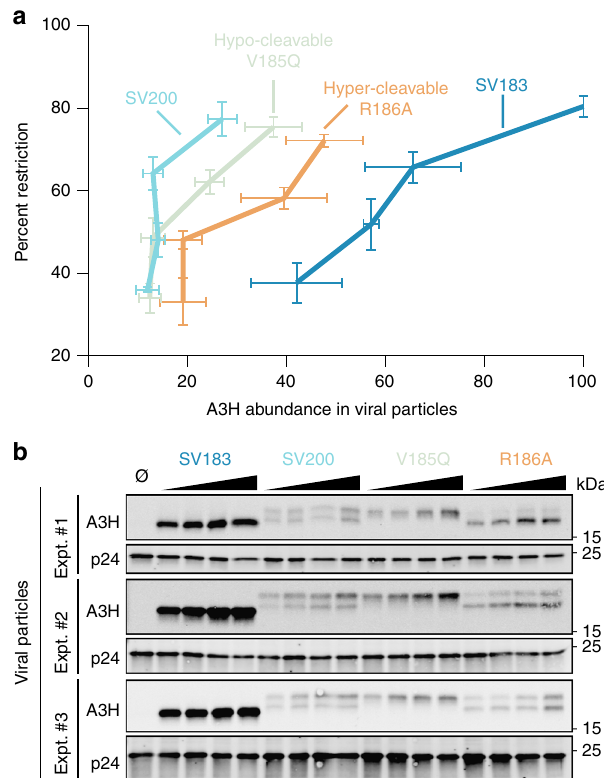
Fig. 6 Quanti fi cation of HIV-1 restriction for A3H haplotype II SV200 and hypo- and hyper-cleavable derivatives. a Dose – response summary of infectivity data for Vif-de fi cient HIV-1 LAI produced in 293T cells in the presence of the indicated untagged A3H splice variants (12.5 ng, 25 ng, 50 ng, or 100 ng) and infectivity quanti fi cation by fl ow cytometry of infected CEM-GFP reporter T cells. Each data point represents the mean of three biologically independent experiments. The percent restriction values ( y - axis) were obtained by normalization to no A3 control reactions (mean ± SEM). Relative A3H abundance in viral particles ( x -axis) was determined by normalization to p24 levels (mean ± SEM; see main text and methods for additional details). b Immunoblots of A3H and p24 in virus particle lysates for the three biologically independent experiments quanti fi ed in ( a